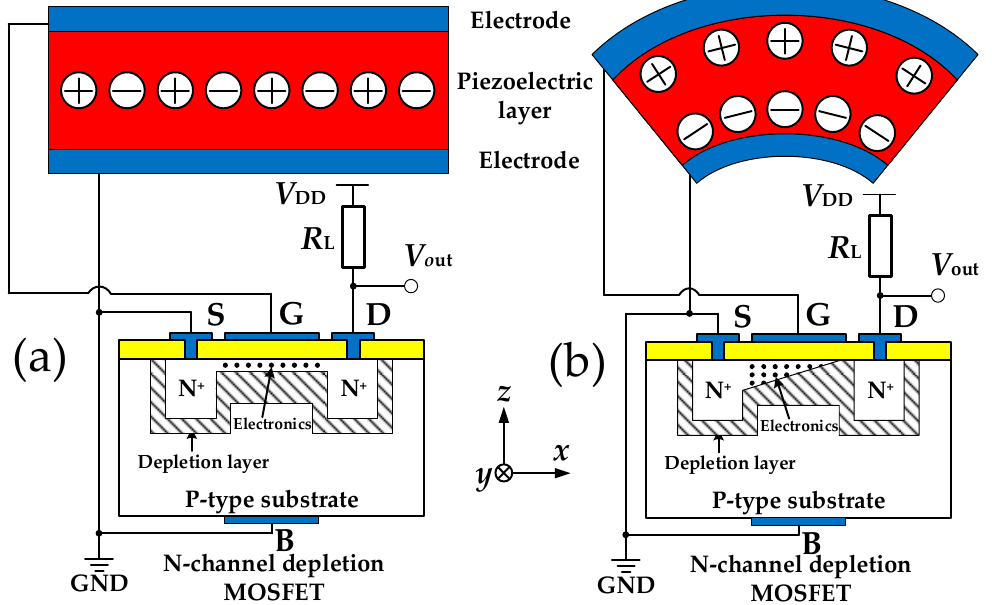
Figure 3. Working principle of piezoelectric PMAS: ( a ) without external acceleration; ( b ) with external acceleration.